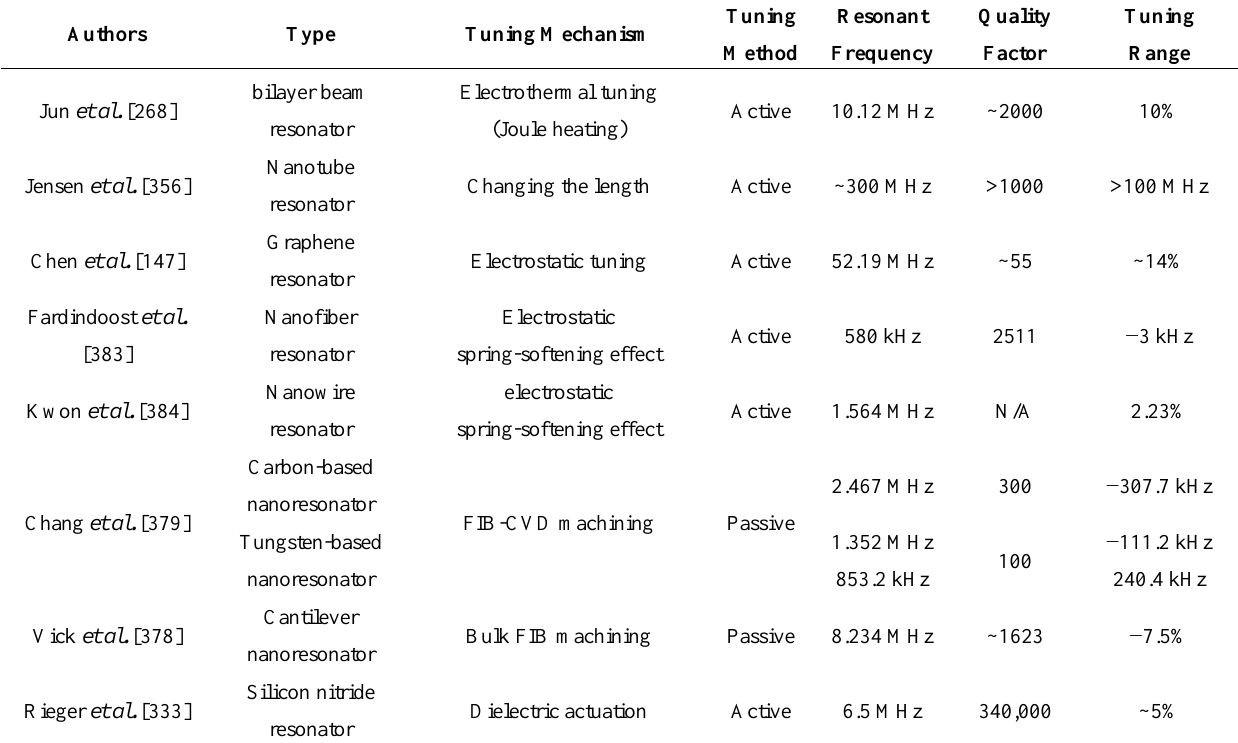
Figure 36. Post-packaging frequency tuning process using PLD [89]. ( a ) Schematic diagram of the PLD tuning process; ( b ) Microresonator surface after PLD tuning process; ( c ) Spectrum measurement of a resonator before and after the PLD frequency tuning process. Reused with permission from IOP Publishing. Table 9. Comparison of some frequency tuning mechanisms and techniques for nanomechanical resonators. (Note: negative value denotes tuning